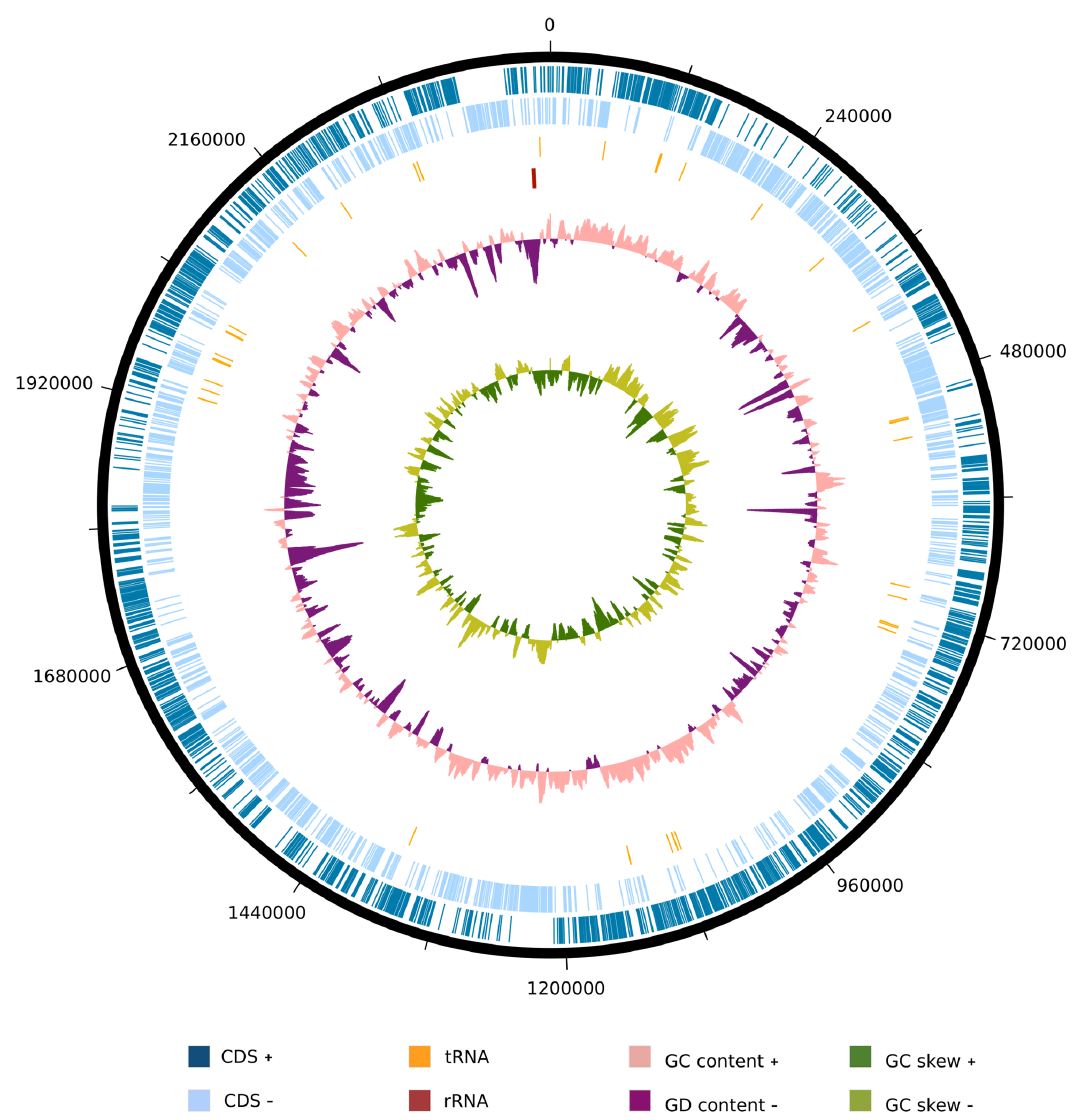
Figure 3. Graphical circular map of O. lakotia SW165 T genome. From outside to the center: coding sequences on the forward strand (CDS +), coding sequences on the reverse strand (CDS -), tRNAs, rRNAs, GC content, and GC skew.